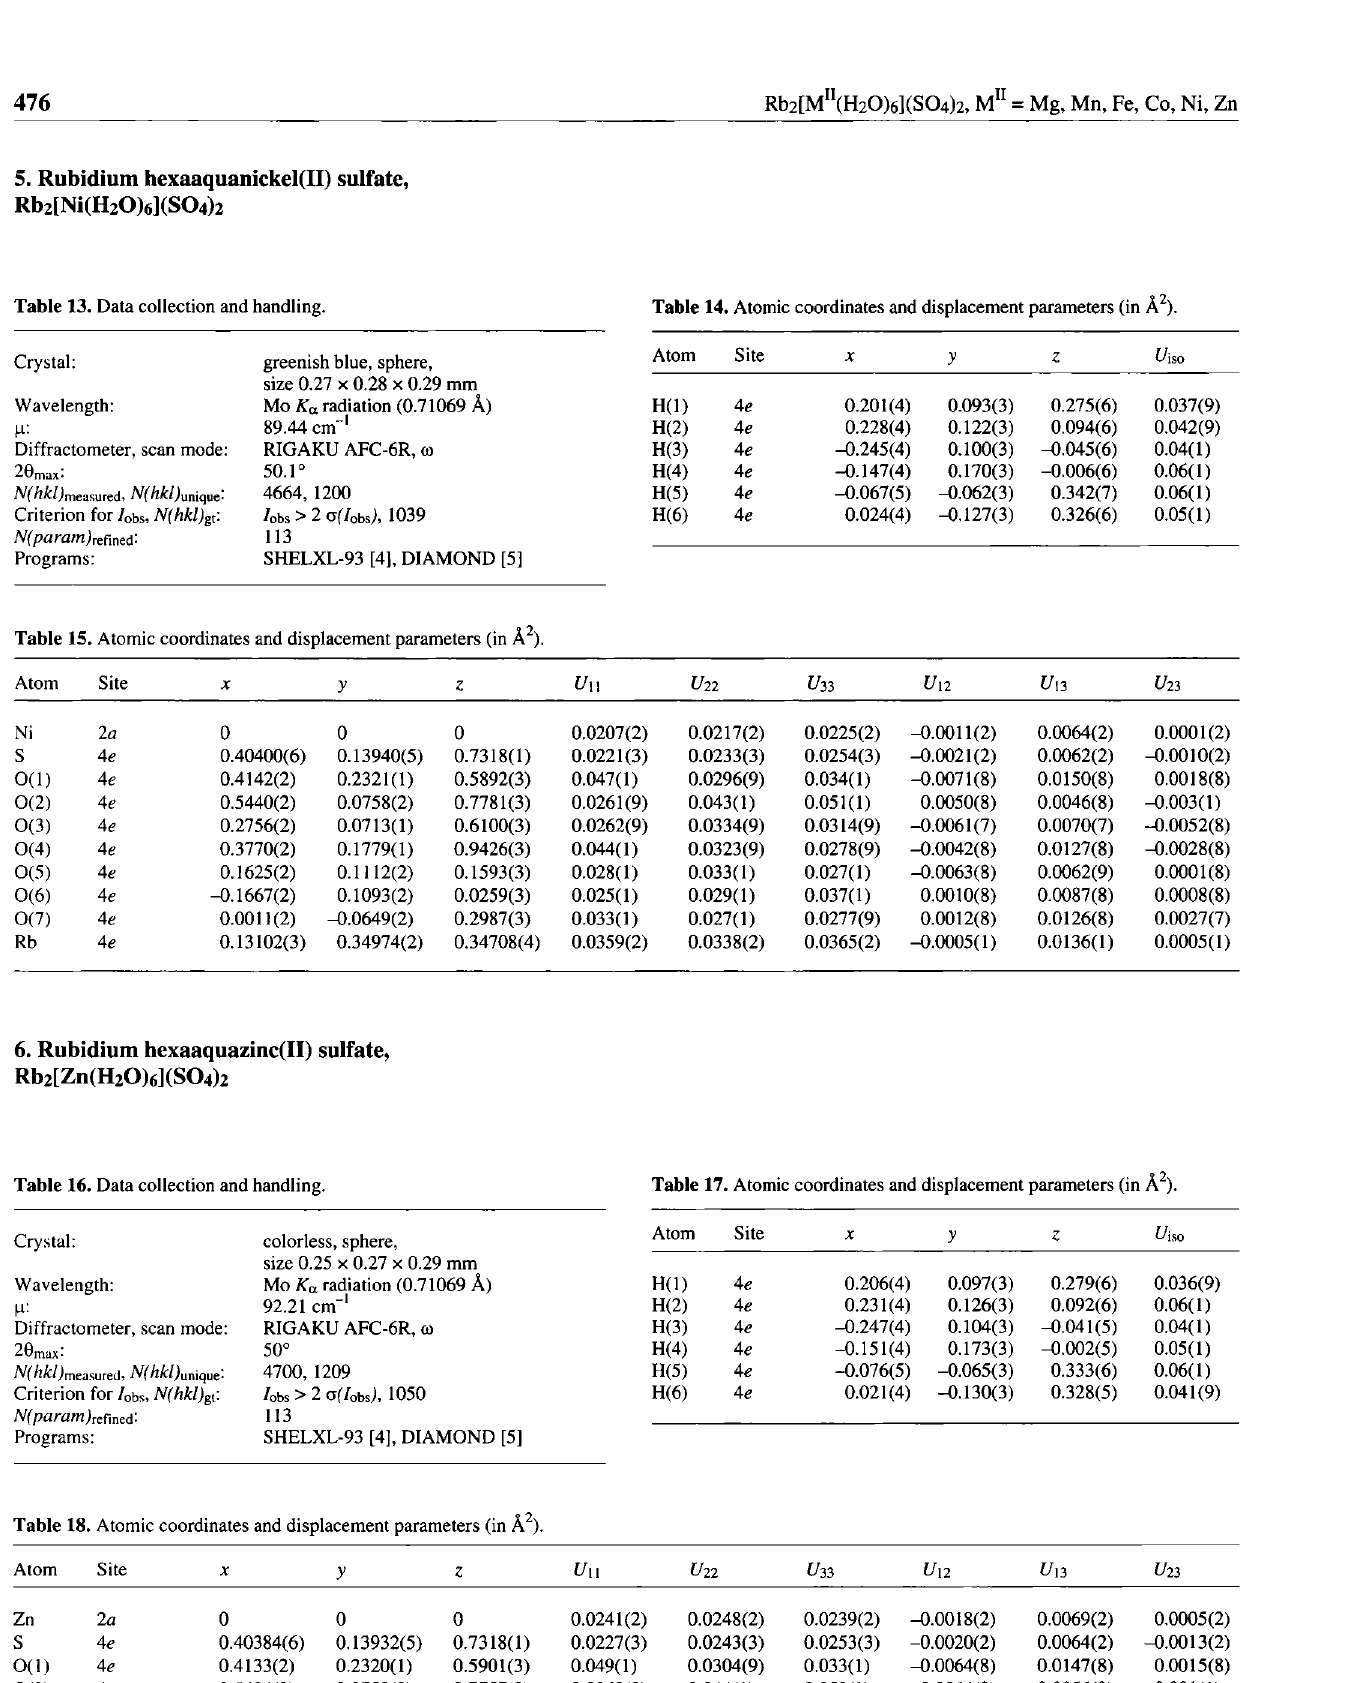
Table 18. Atomic coordinates and displacement parameters (in A 2